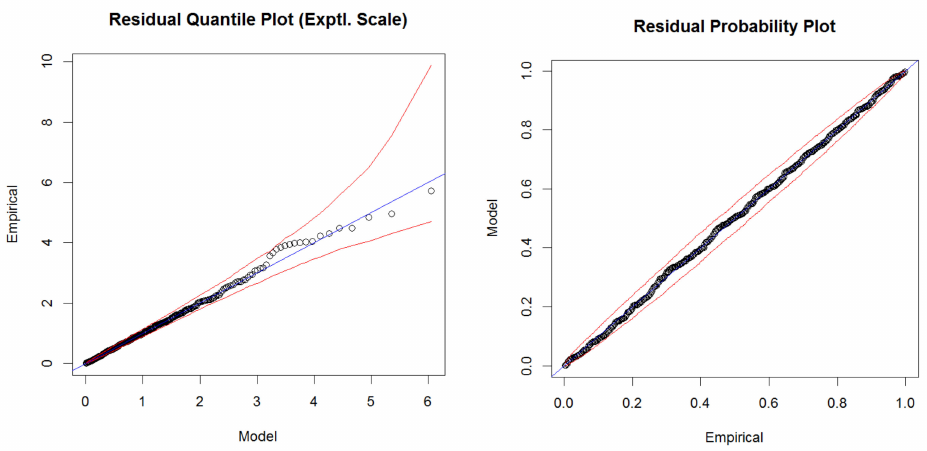
Figure A8. QQ plot ( left ) and PP plot ( right ) when using the data of both Salzburg and Styria.